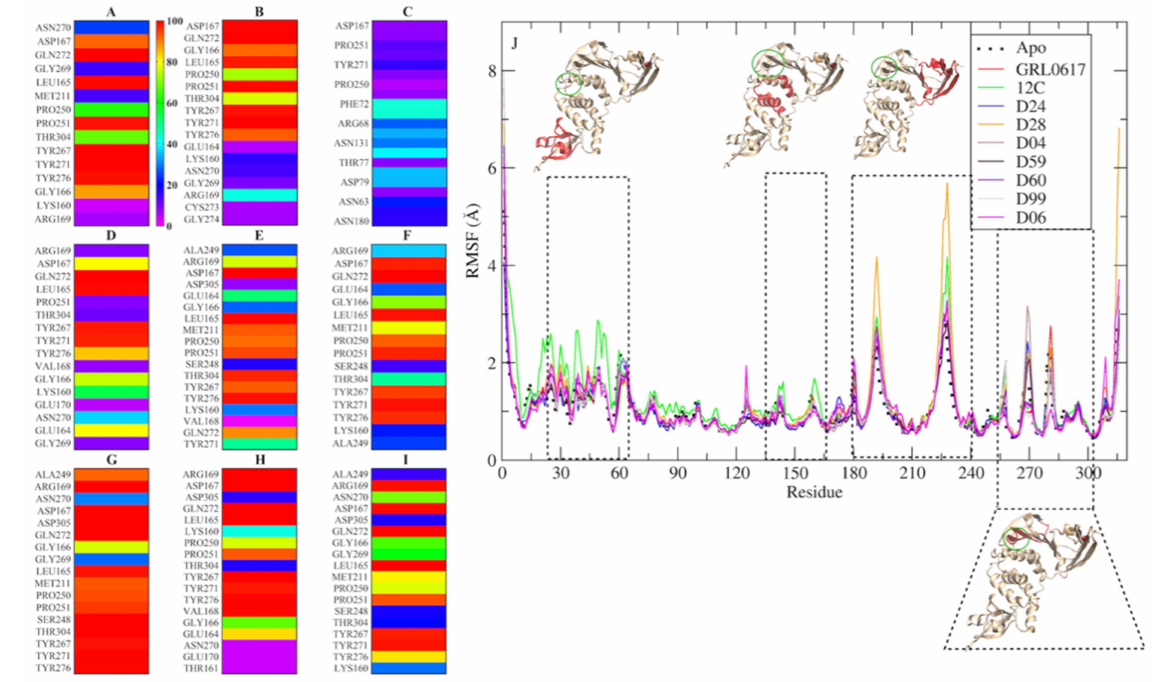
Figure 4. Residues of less than 3 Å ( A – I ) of the ligands and the perturbation they generate in the protein structure ( J ) during MD simulation. Simulations of 200 ns of GRL0617, 12C, D28, D04, D59, D60, D99, and D06 ( A , B , D , E , F , G , and I , respectively) and 400 ns for D24 ( C ) were analyzed, showing the percentage of the simulation in which each ligand (blue 20% to red 100%) was found within 3 Å of the ligand. The perturbation of the protein structure (RMSF) was analyzed during the last 150 ns of each simulation and compared to the protein without ligand or Apo (black dots). In the figure, the region of greatest perturbation is marked (rectangle with a dotted line), and the region affected by the perturbation (red) and the ligand binding site (green circle) are highlighted on the